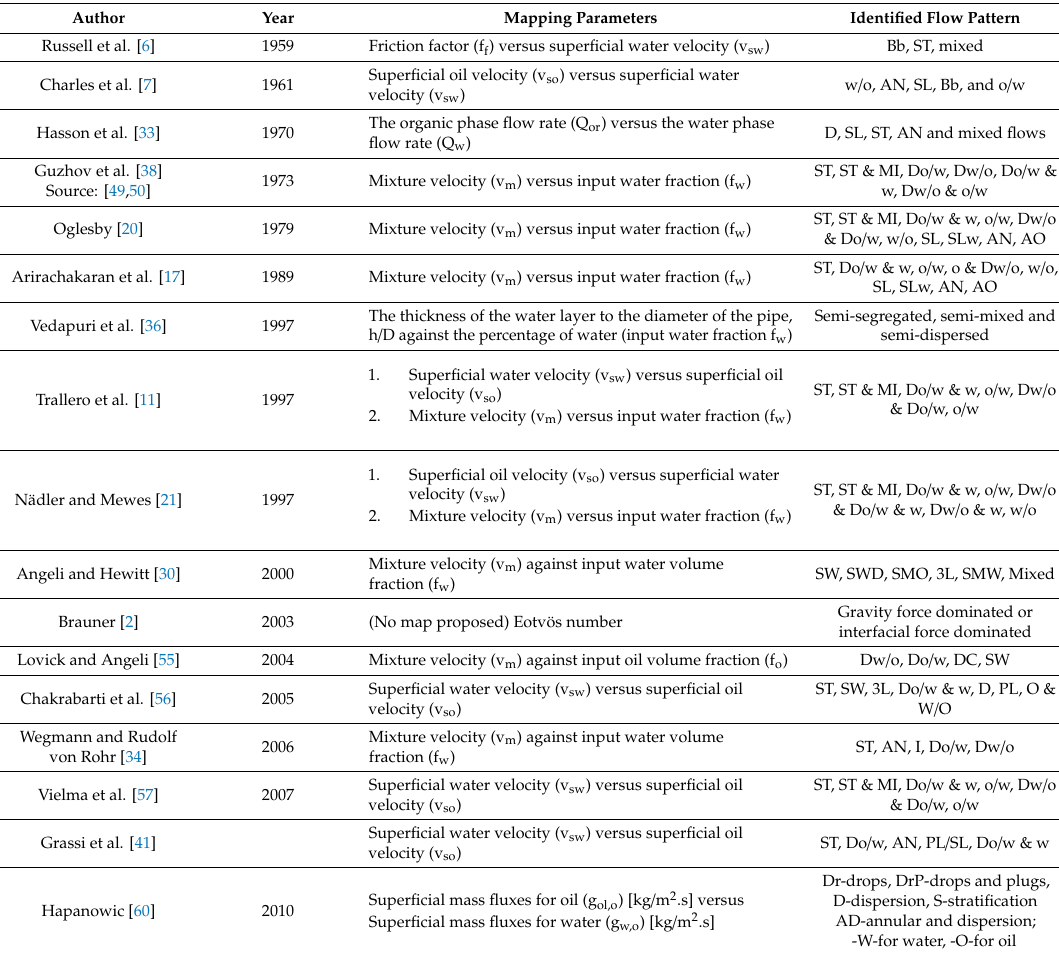
Table 3. Development of flow maps for liquid-liquid in a horizontal